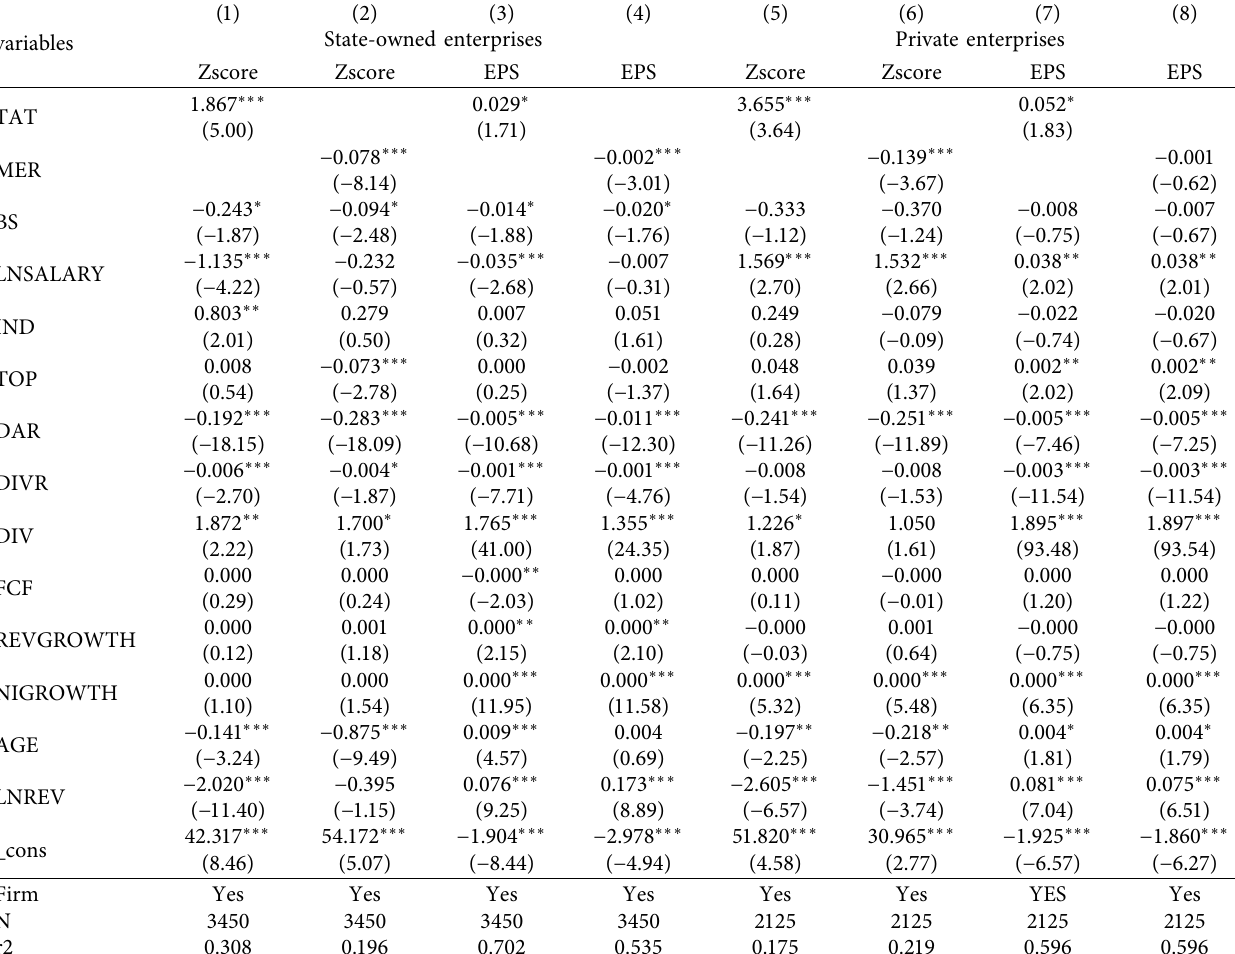
Table 6: Panel OLS regression of the effect of agency cost on corporate sustainable